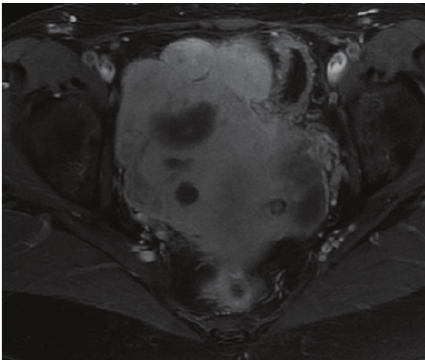
Figure 3: Ectopic adrenal tissue(HE, original magnification is ×